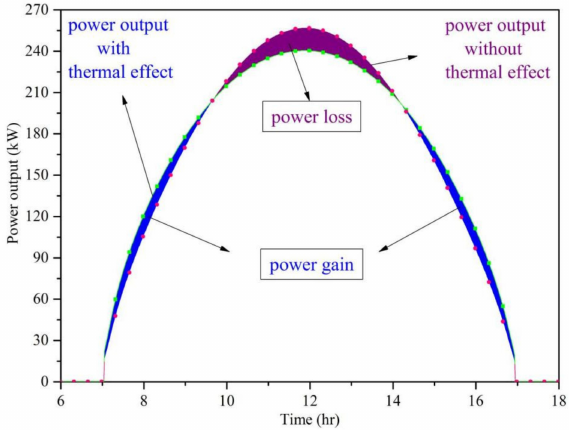
Figure 6. Thermal effect on the power output the winter